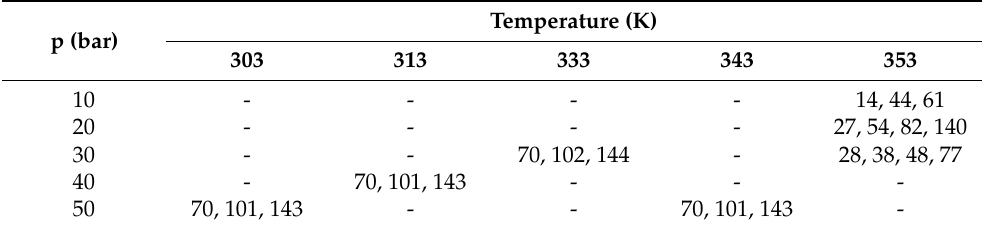
Table 1. Duration of accelerated ageing in autoclaves in days at 5 different temperatures and pressures. p